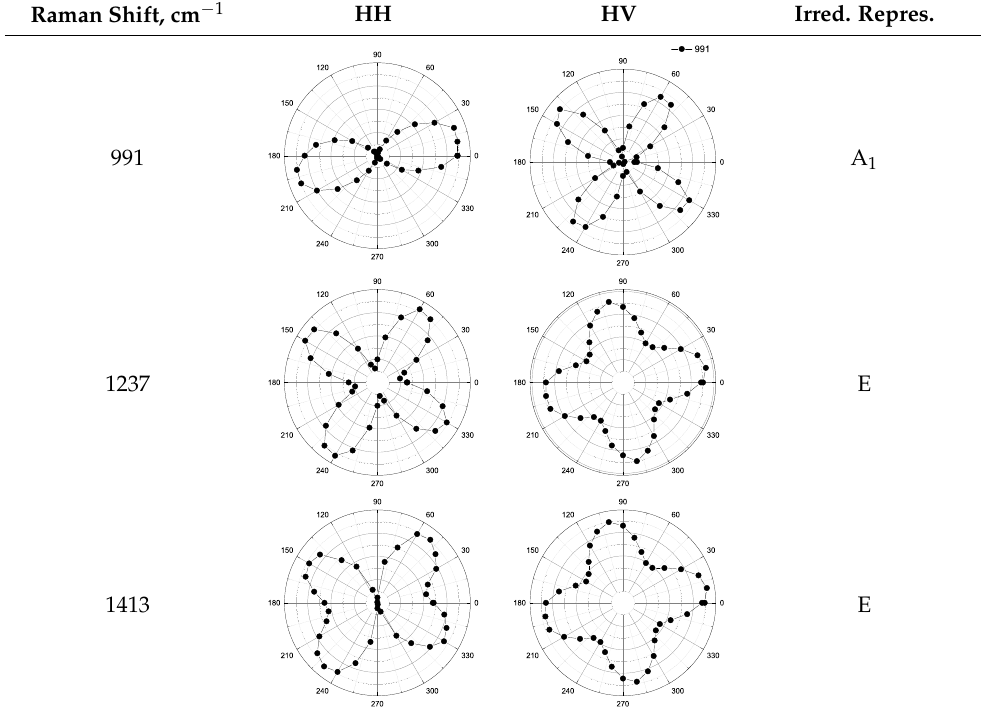
Table 2. Cont. Raman Shift, cm − 1 HH HV Irred.